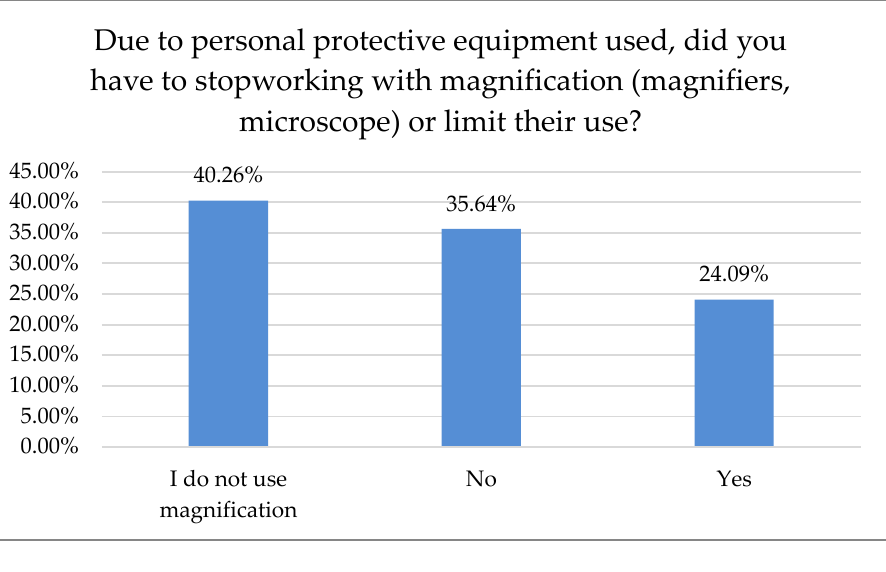
Figure 5. Usage of magnification during the pandemic. Of the respondents, 68.09% reported that the amount of time spent admitting a single patient increased (Figure 6).